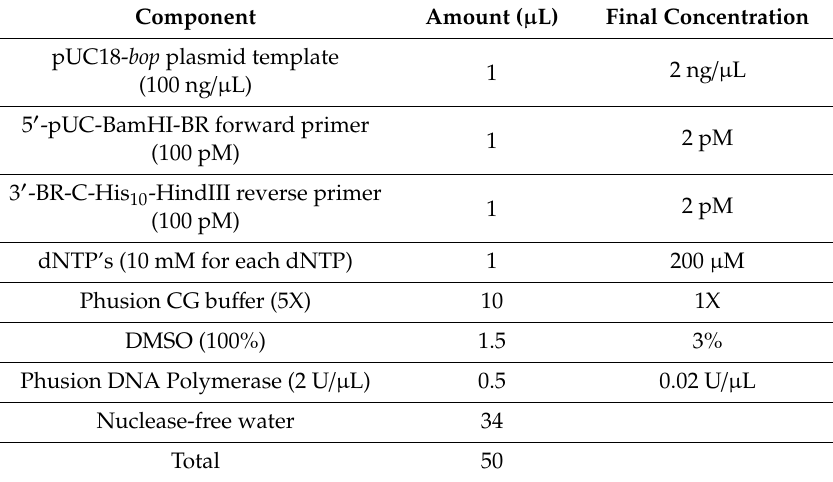
Table 1. PCR reaction mixture for site-directed mutagenesis of the bop